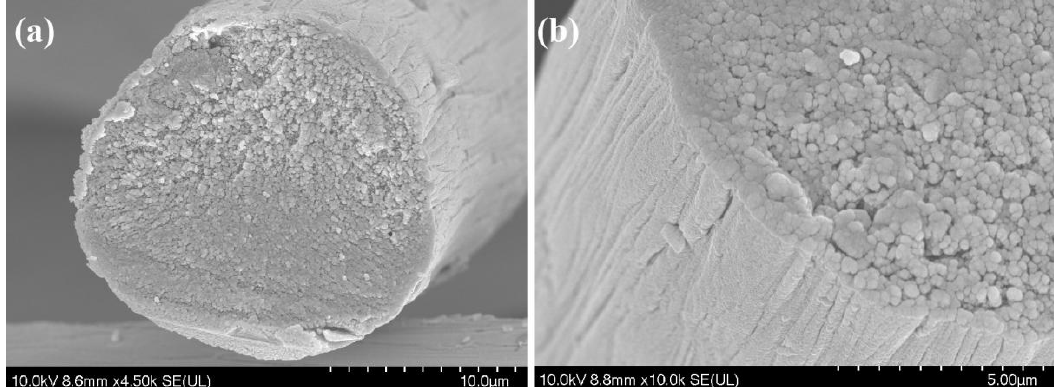
Figure 5. ( a , b ) Amplifying FE-SEM images of Ag 25 -C-fiber substrate from side view.